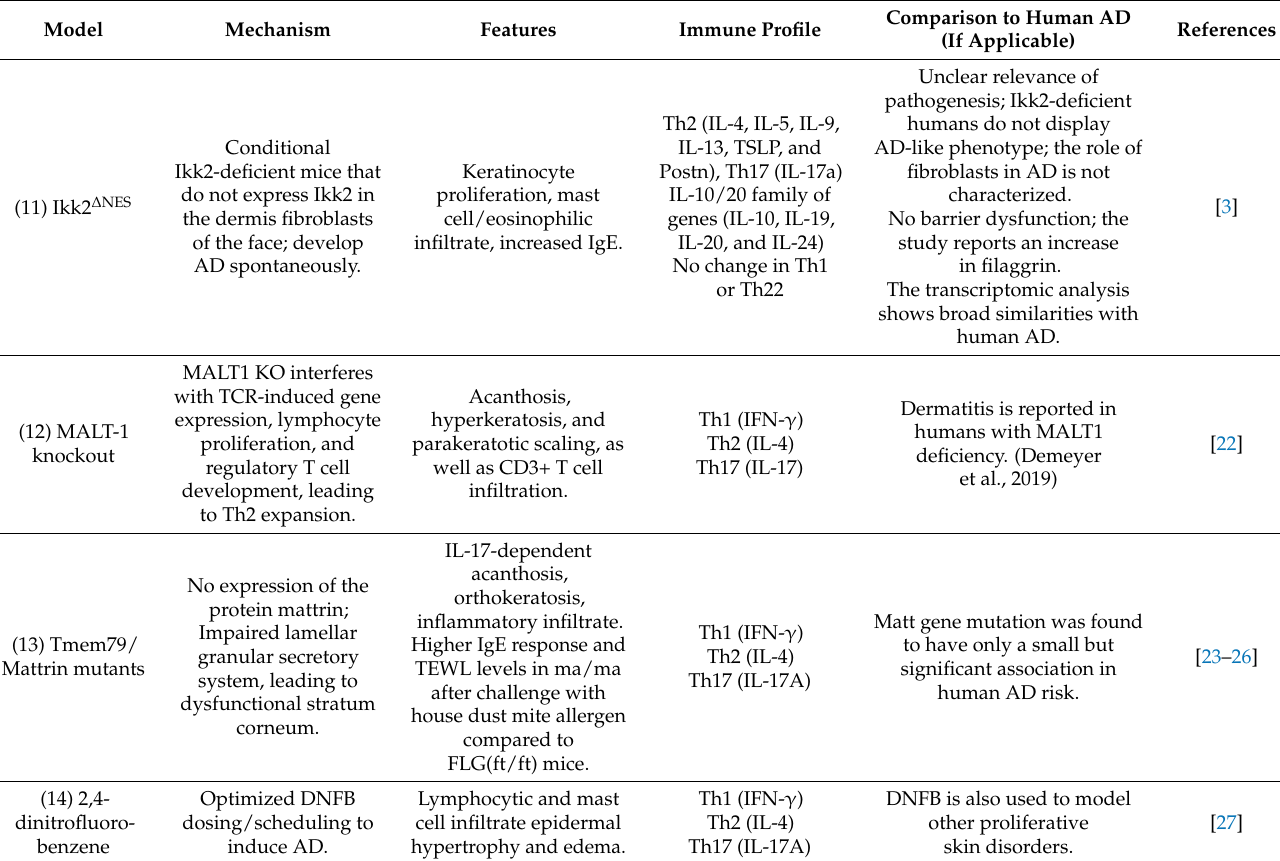
Table 2. Mouse models with Th17, Th2, and/or Th1